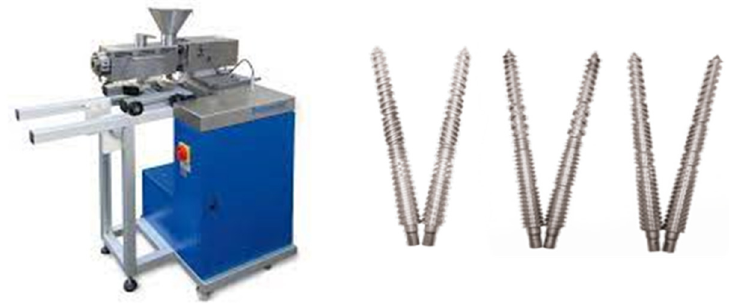
Figure 1. ( Left ) Brabender conical twin screw extruder and ( Right ) Co-rotating conical screws.